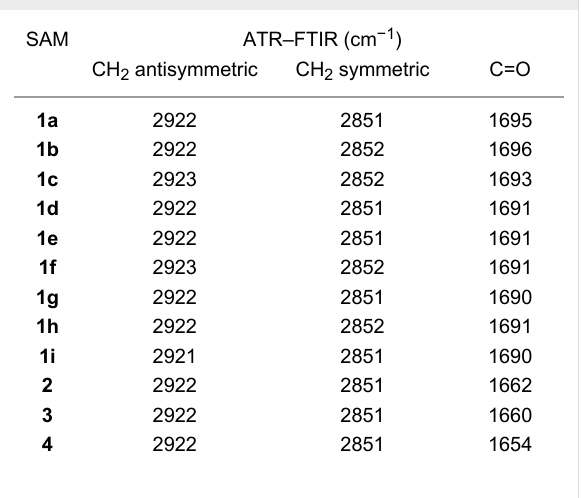
Table 1: FTIR data for SAMs based on compound 1 – 4